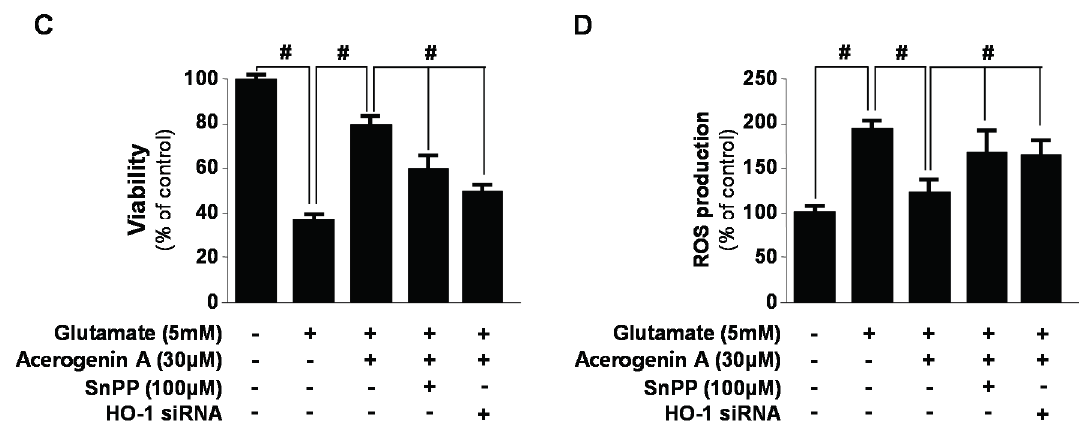
Figure 3. The effects of acerogenin A on heme oxygenase (HO)-1 expression ( A , B ) and acerogenin A-induced HO-1 on glutamate-induced oxidative neurotoxicity ( C ) and ROS generation ( D ). HT22 cells were incubated with indicated concentrations of acerogenin A for 12 h ( A , B ). HT22 cells were treated with 30 μ M of acerogenin A in the presence or absence of 50 μ M SnPP IX and HO-1 siRNA, and then exposed to glutamate (5 mM) for 12 h ( C , D ). Exposure of HT22 cells to 5 mM glutamate for 12 h to increase ROS production, followed by incubation with 10 μ M of the ROS-sensitive fluorophore dichlorofluorescein (DCF) ( D ). Western blot analysis was performed, and representative blots of three independent experiments are shown. Data are presented as the mean ± SD values of three independent experiments. * p < 0.05 vs . control. # p <